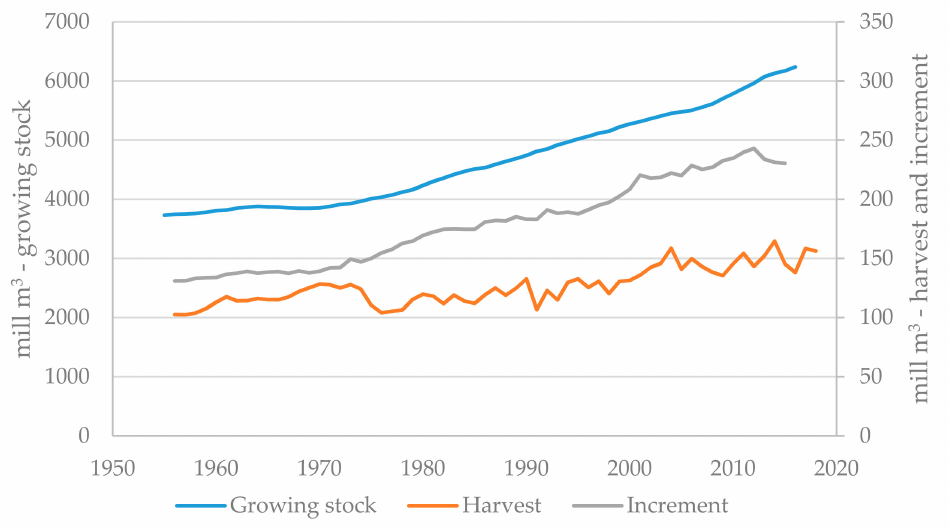
Figure 3. Nordic (Norway, Sweden and Finland) growing stock (left axis), yearly harvest (right axis) and increment (right axis). Source: